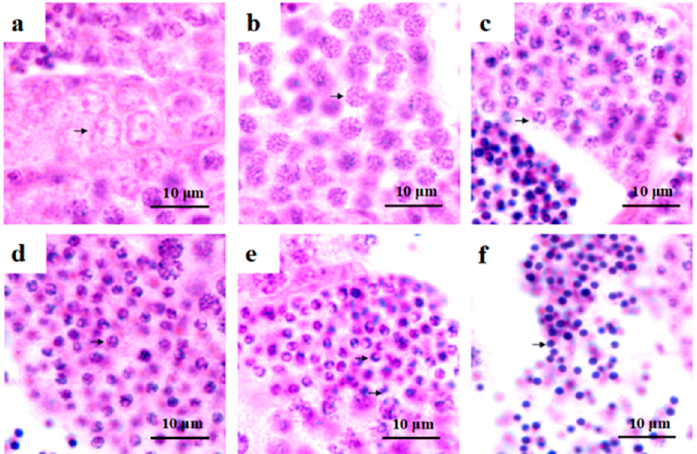
Figure 2. Histological observations of spermatogenesis in O. bidens. ( a – f ) Spermatogenic cells were processed by paraffinized sectioning. ( a ) Spermatogonia; ( b ) Primary spermatocyte; ( c ) Secondary spermatocyte; ( d ) Early spermatid; ( e ) Middle spermatid; ( f ) Sperm.